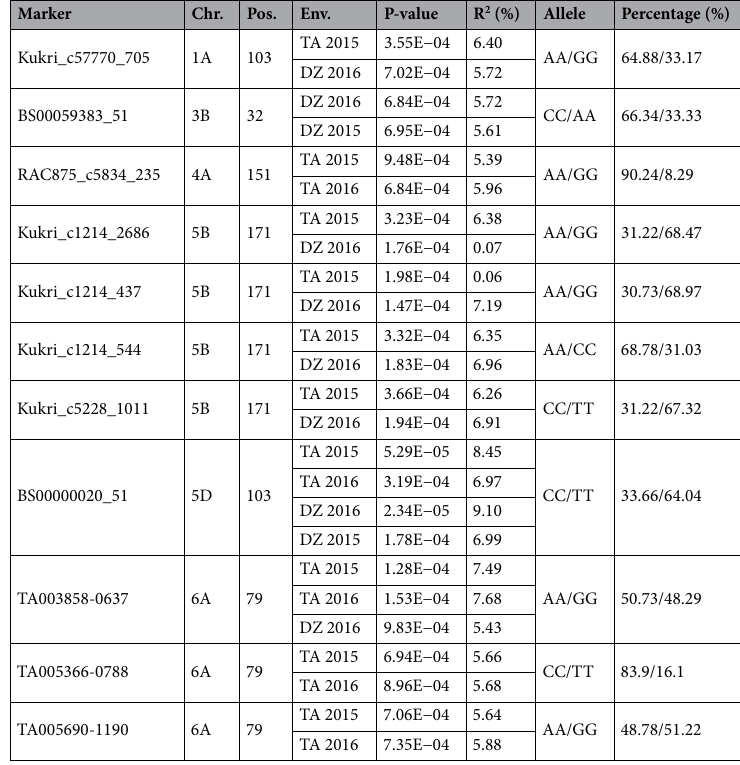
Table 6. SNP markers significantly associated with the yellowness index (b* value) of flour colour in two locations in 2 years (P < 10 –4 ). Chr. chromosome, Pos. position, Env.